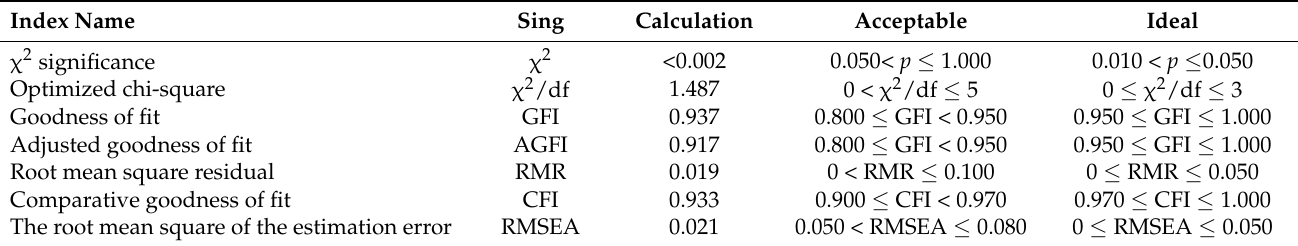
Table 5. The goodness of fit criteria of the